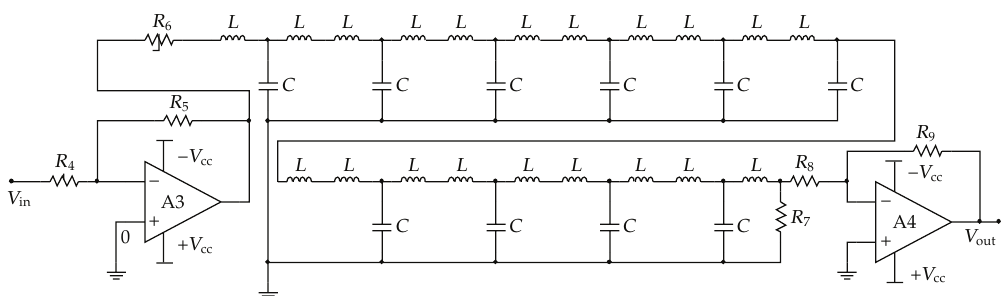
Figure 8: Circuit implementation of the time delay